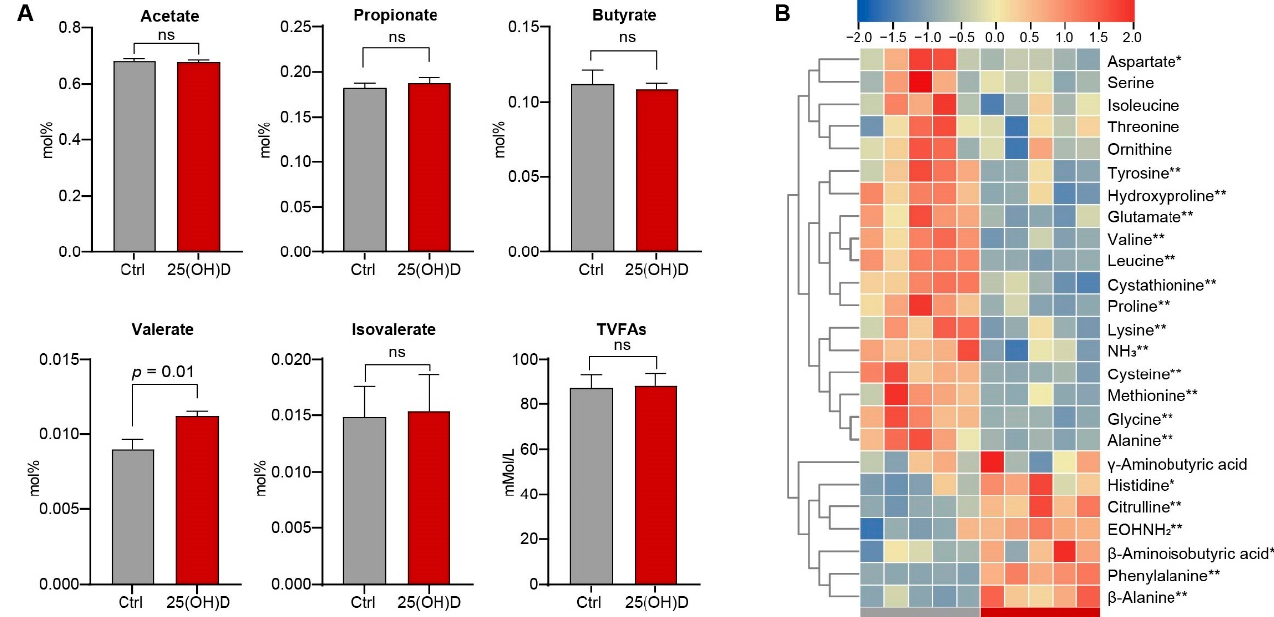
Figure 2. The changed production of VFAs and amino acids in rumen liquid between the Ctrl and 25(OH)D groups. ( A ) Comparison of VFAs in the rumen liquid between the Ctrl and 25(OH)D groups. ns means no significant differences. ( B ) Heatmap showing the concentrations of amino acids in rumen liquid between the Ctrl and 25(OH)D groups. Square colors indicate the amino acids concentration from low (blue) to high (red). Samples from the Ctrl group and 25(OH)D group were indicated by grey and red bars at bottom of heatmap. p value indicates the statistical significance of the differences, and were determined using WRS test based on the Benjamini–Hochberg correction. ** and * indicate p < 0.01 and p < 0.05, respectively. TVFAs: Total Volatile Fatty Acids.